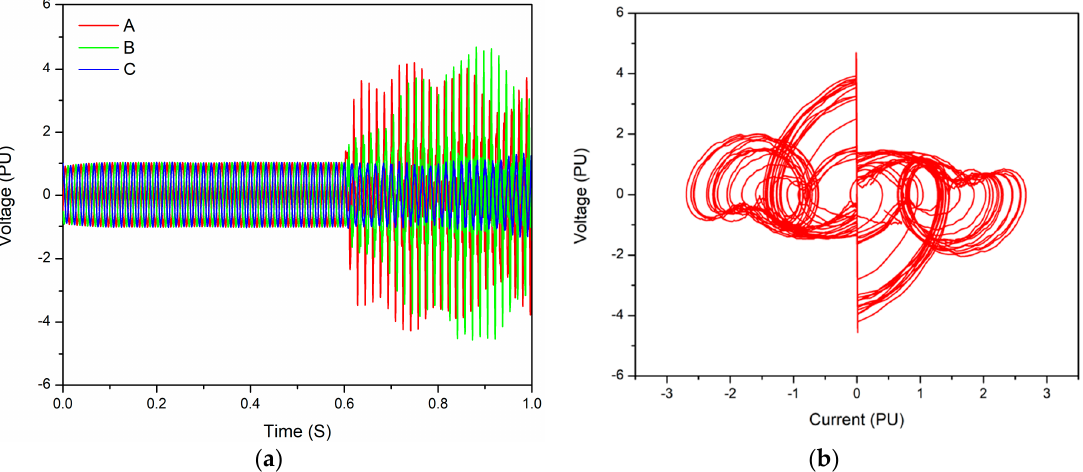
Figure 13. The ferroresonant results during de-energization at 0.6 secs on the DFIG wind turbine: ( a ) Voltage waveform, with highest overvoltage on phase B; ( b ) Phase plane diagram of phase b showing chaotic